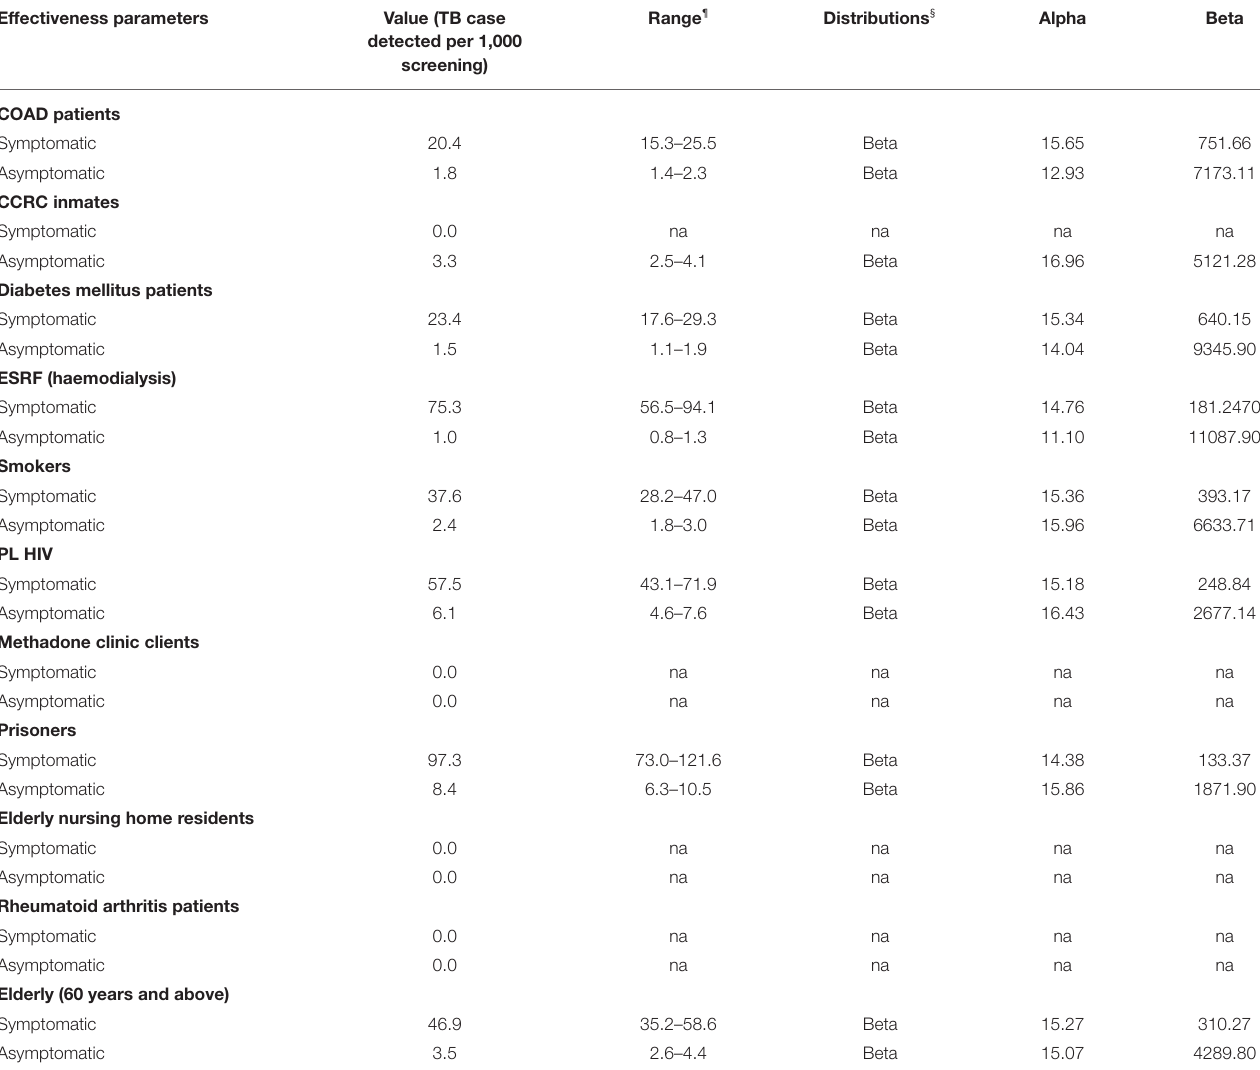
TABLE 3 | Clinical input data for